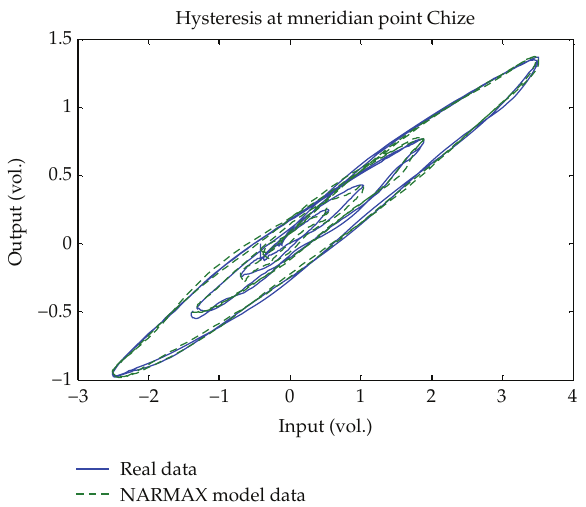
Figure 4: Model validation of the NARMAX model for hysteresis in meridian.